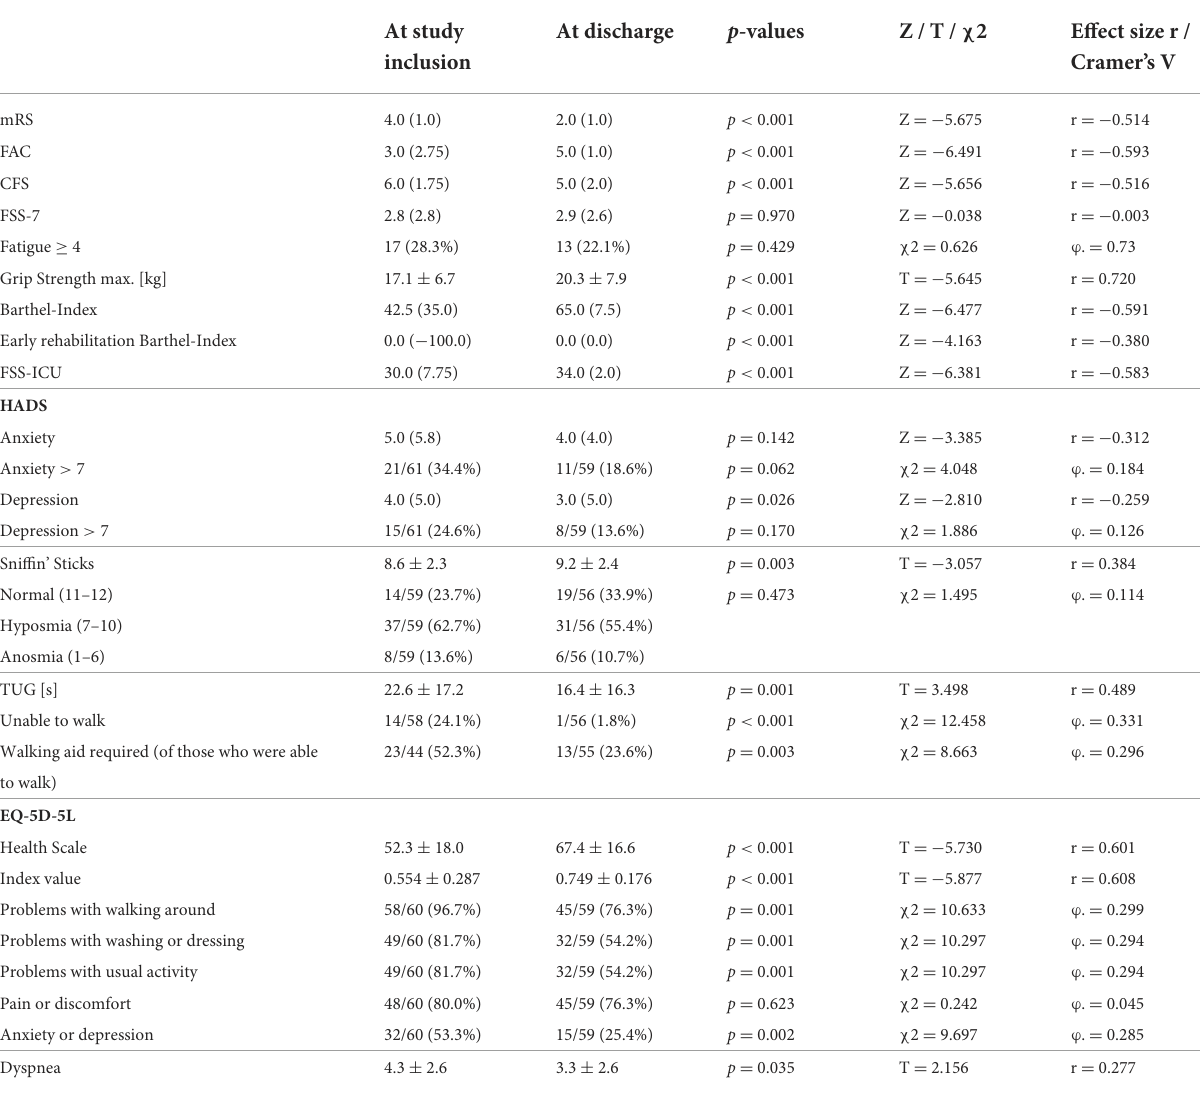
TABLE 3 Results of the questionnaires and functional